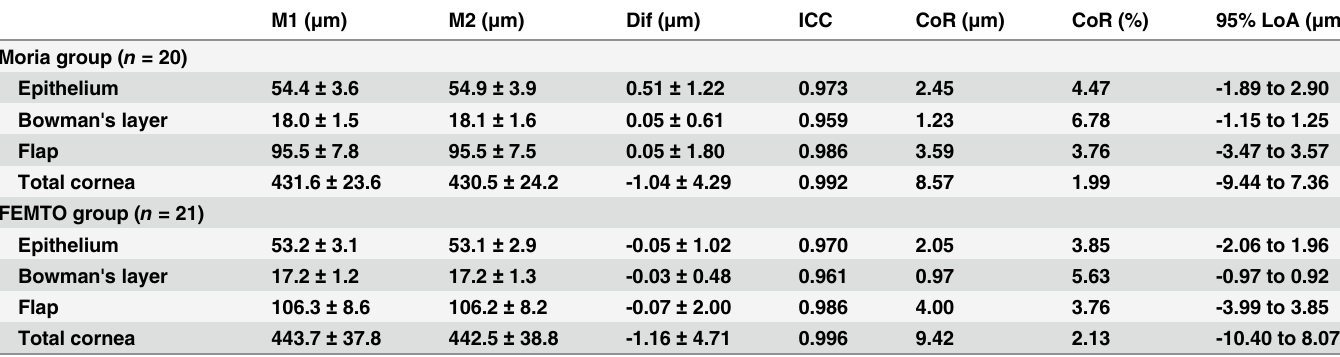
Table 1. Repeatability of automated UHR-OCT image processing algorithm for the Moria and FEMTO groups.